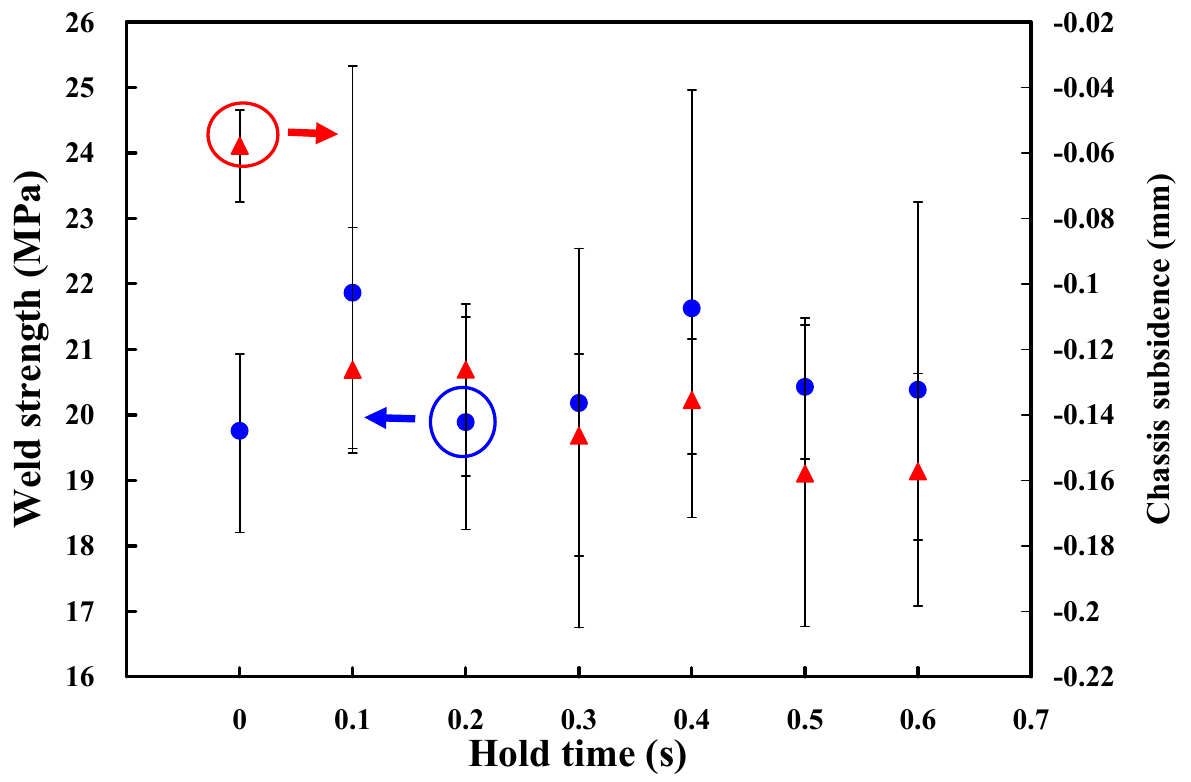
Figure 9. Effects of the different hold times on weld strength and chassis subsidence. Table 2. Tensile testing results. Table 1. Process control factors and their levels.